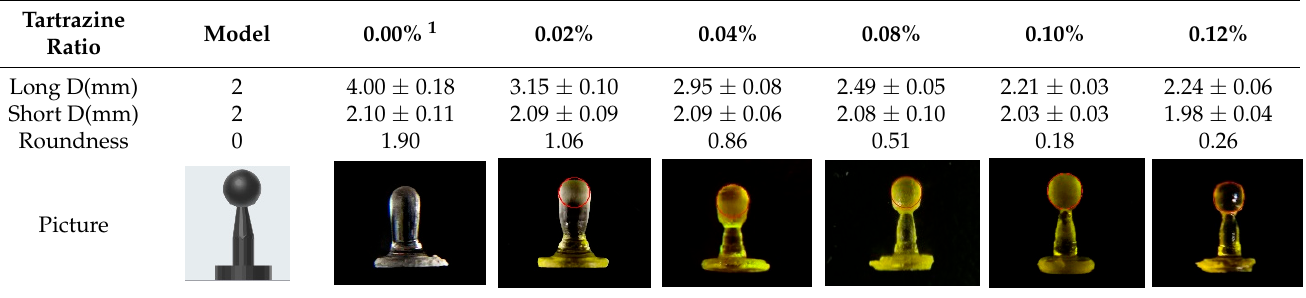
Table 2. Measured parameters of tartrazine content in printed pellets ( n = 10).